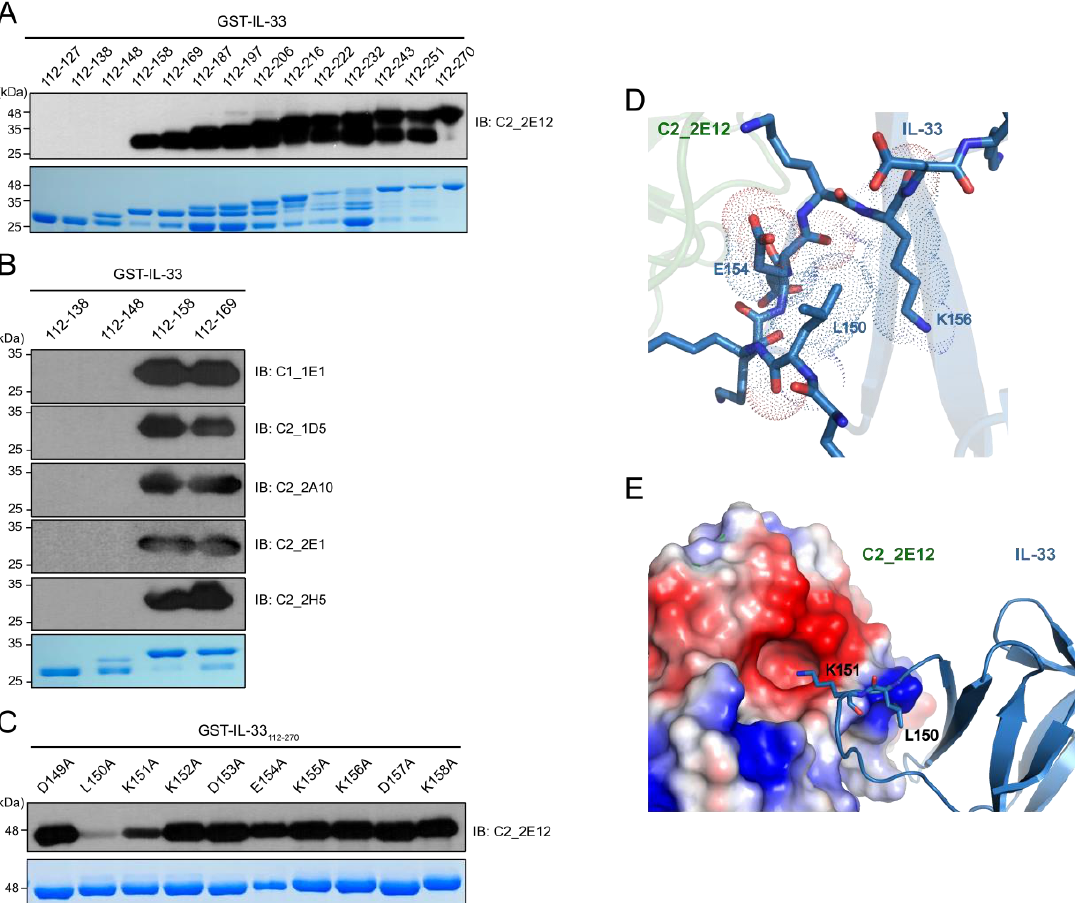
Figure 2. Epitope mapping of C2_2E12. ( A ) Immunoblot analysis of 14 GST-IL-33 deletion mutants to map the IL-33 epitope at secondary structural element level for scFv clone C2_2E12. Residue numbers of the mutants are shown. ( B ) Immunoblot analysis of four GST-IL-33 deletion mutants to map the IL-33 epitopes for scFv clones C1_1E1, C2_1D5, C2_2A10, C2_2E1, and C2_2H5. ( C ) Immunoblot analysis of alanine scanning for GST-IL-33 149 - 158 for recognition by the scFv clone C2_2E12. Residue numbers and identities are shown. In panels ( A ) through ( C ), Coomassie Blue stained gel is shown at the bottom. Amount of the loaded protein per lane was 1 μg. The scFv clones were used as the primary antibody (0.5 mg·ml -1 , 1:100 dilution), and anti-HA-HRP was used as the secondary antibody (0.2 mg·mL -1 , 1:5000 dilution). ( D , E ) The HADDOCK-derived molecular docking of C2_2E12 (green) to IL-33 (PDB: 4KC3, blue) complex. A homology structural model for C2_2E12 was generated using